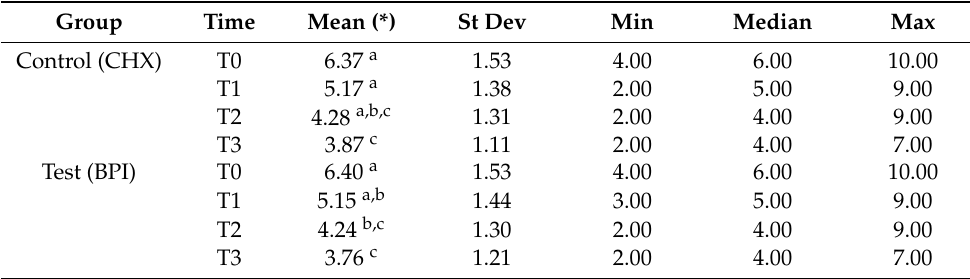
Figure 1. Flow chart of the study. Table 1. Descriptive statistics of probing pocket depth measurements